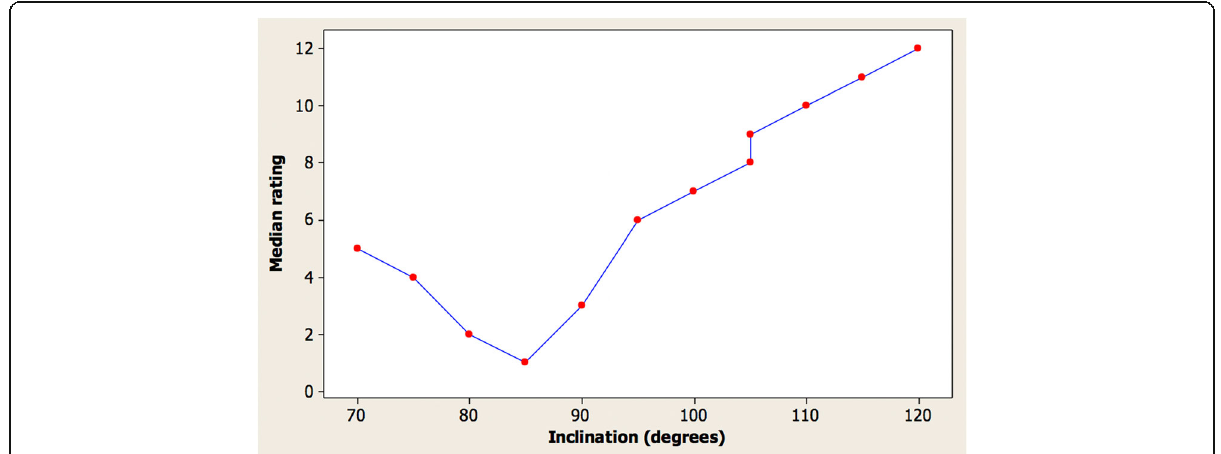
Fig. 4 Graph of the median clinician ratings for the female images